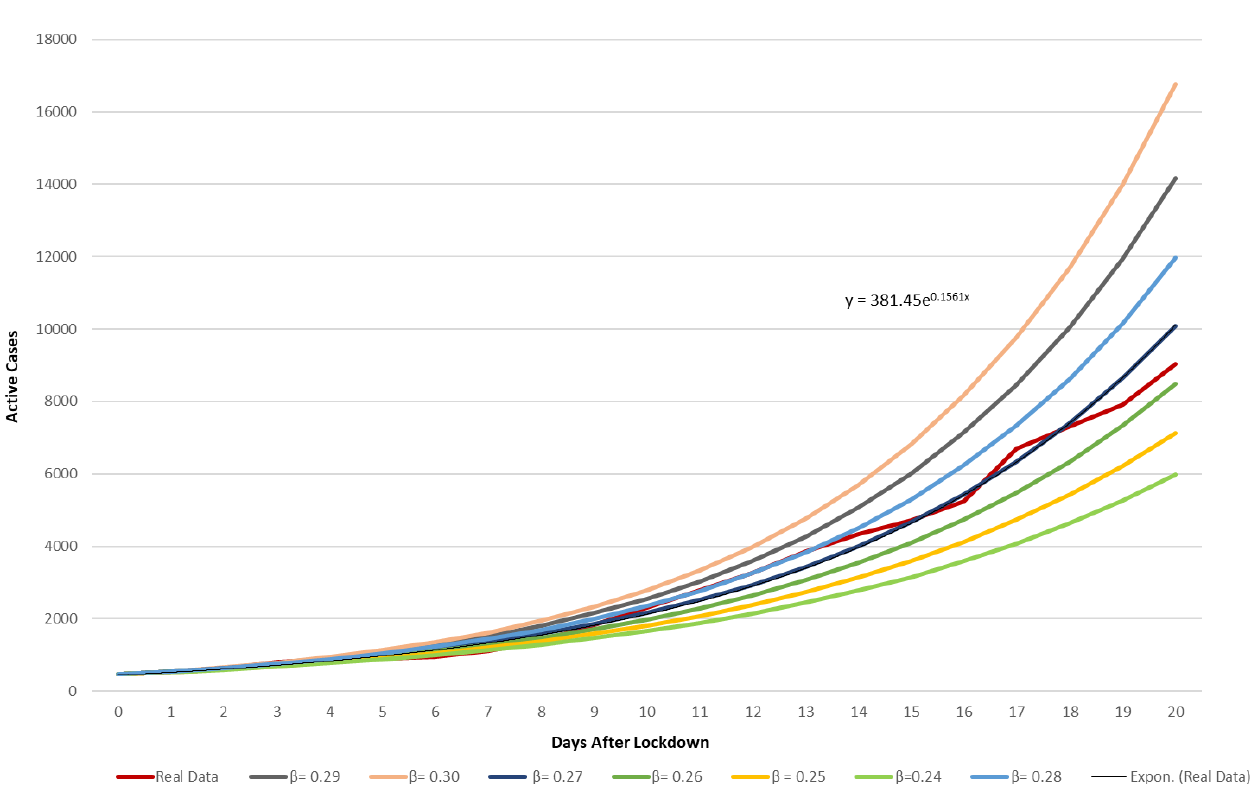
Figure 3. Estimation of β from Indian data. Datasource: https://www.statista.com/statistics/1104054/india-coronavirus-covid-19-daily- confirmed-recovered-death-cases/